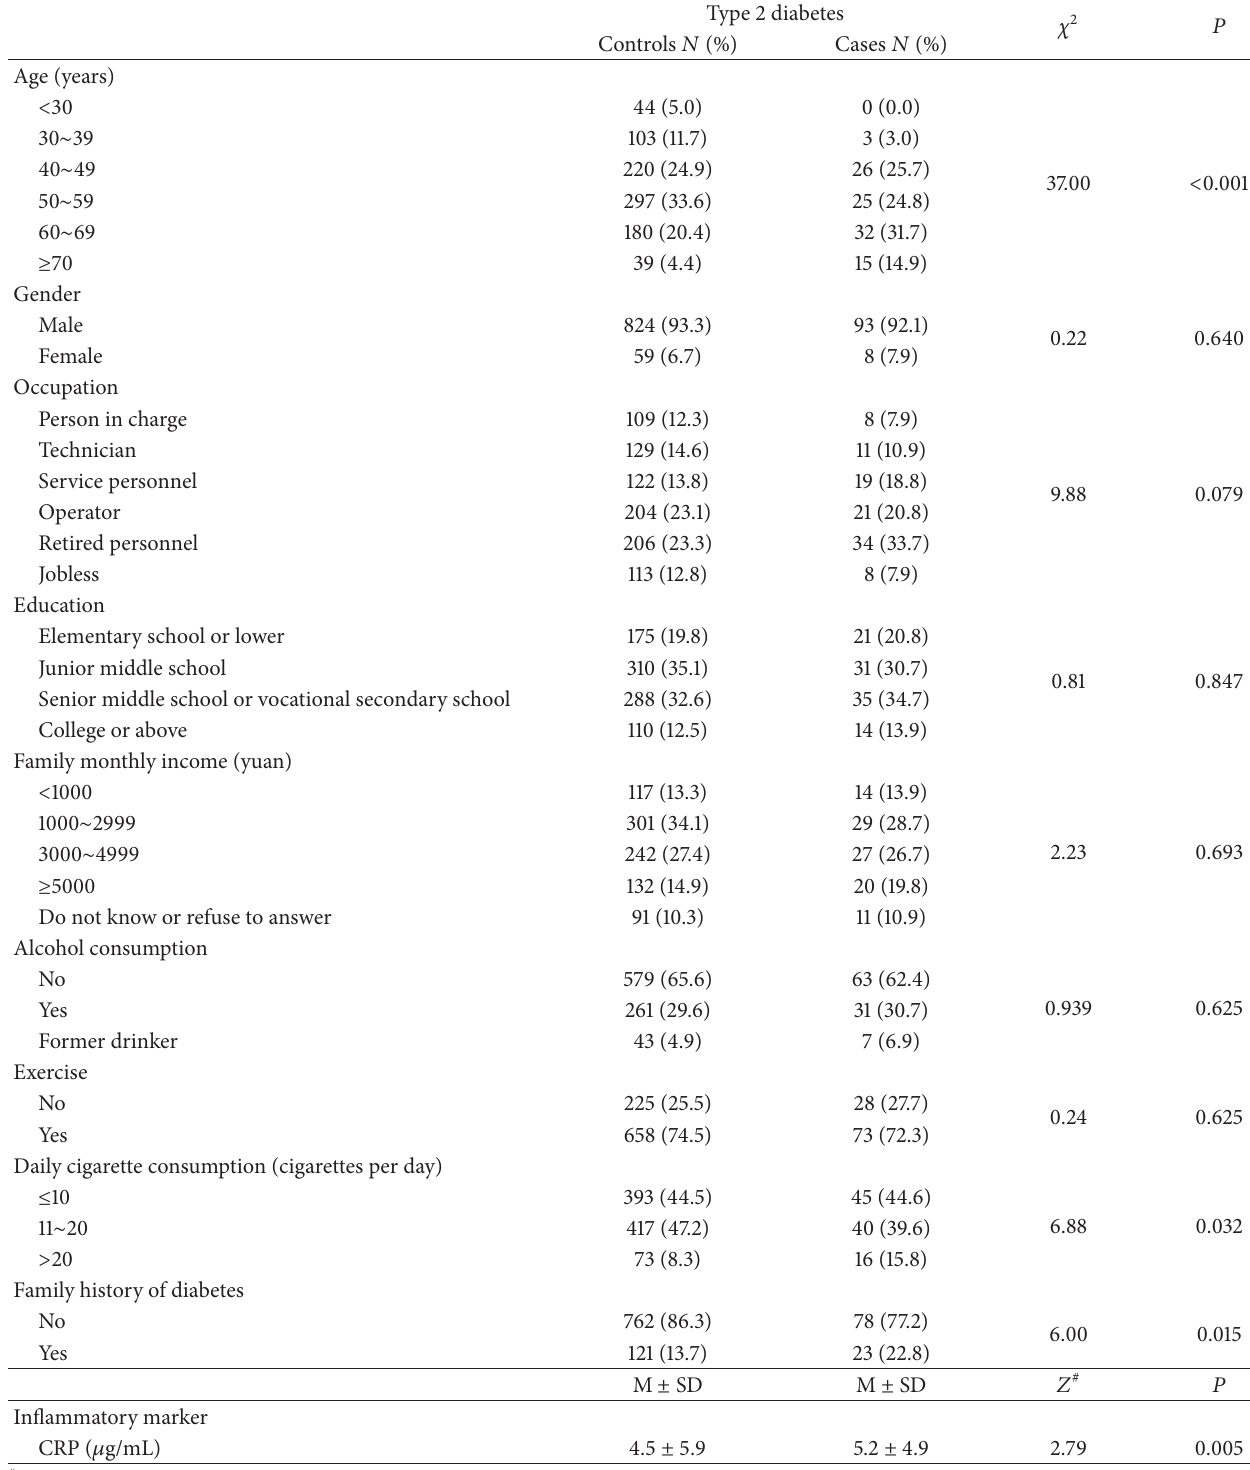
Table 1: Comparison of social-demographic characteristics between type 2 diabetes and non-type 2 diabetes current